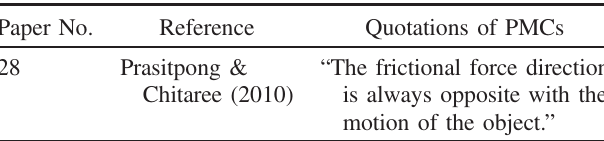
TABLE II. The table used to collect data during the research process (columns related to bibliometrics of papers